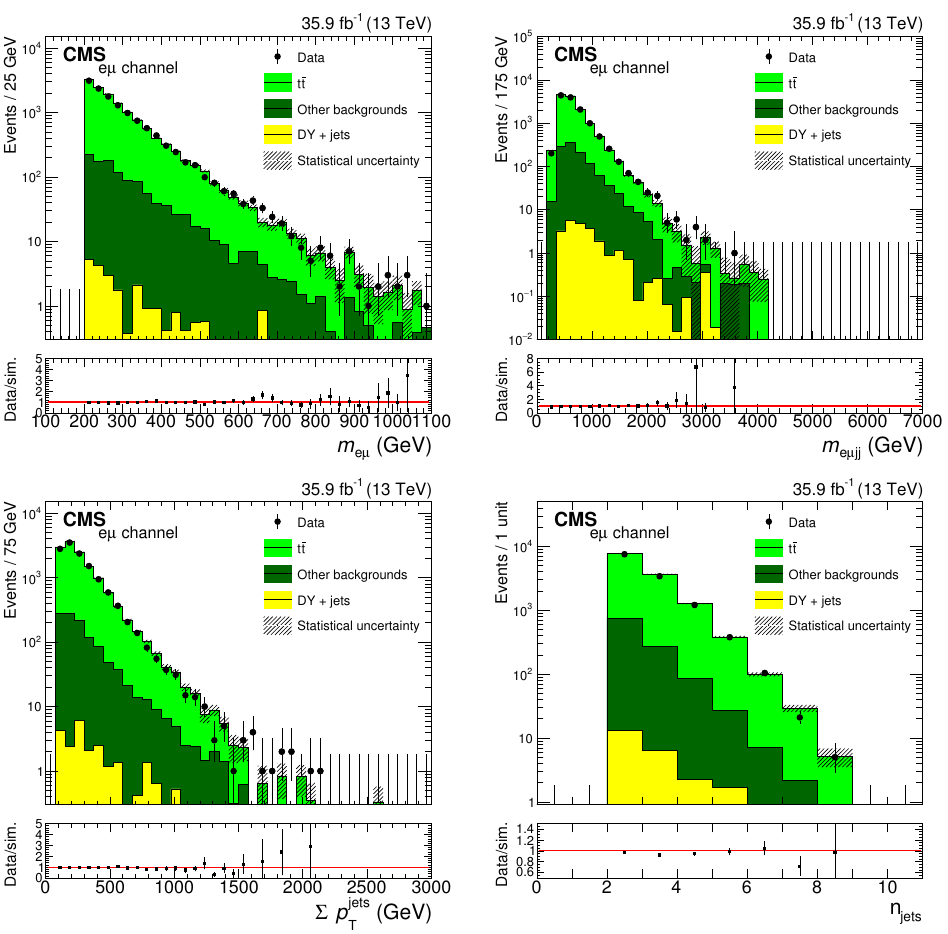
Figure 3 . Kinematic distributions for events in the (cid:13)avor control region with the DY SF applied. The dilepton mass (upper left), the m ‘‘ jj (upper right), the scalar sum of all jet transverse momenta (lower left), and the number of jets (lower right) are shown. The uncertainty bands on the simulated background histograms include only statistical uncertainties. The uncertainty bars in the ratio plots represent combined statistical uncertainties of data and